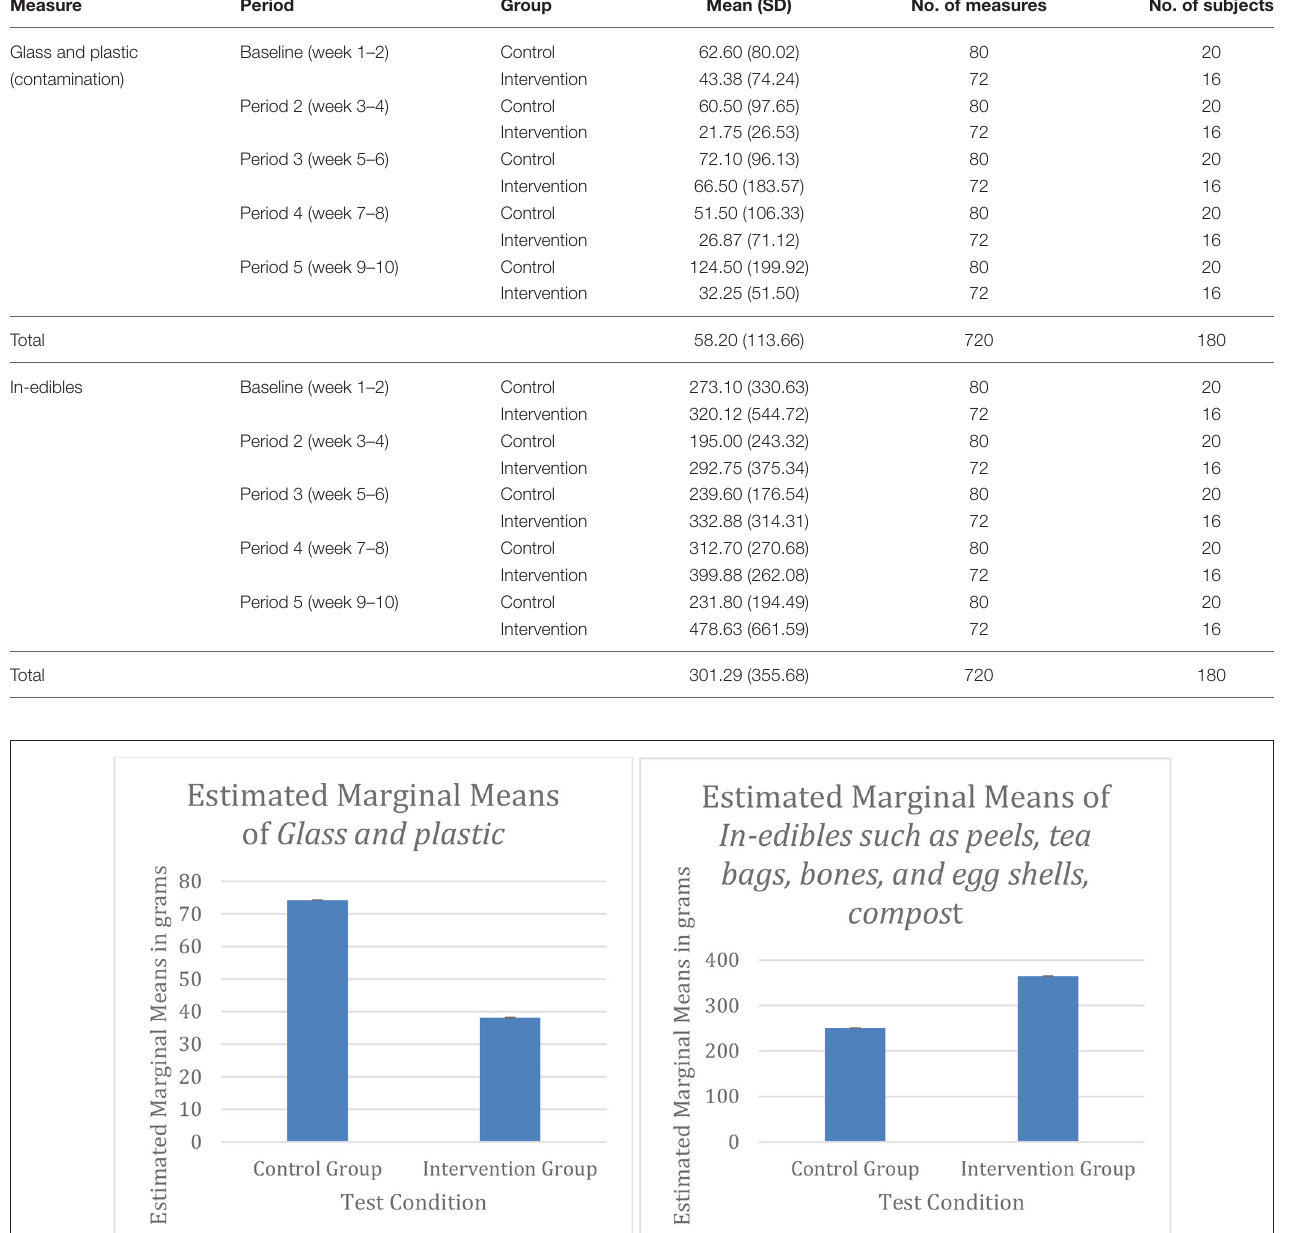
the store more. I thought it was worth it rather than wasting a lot of food.”